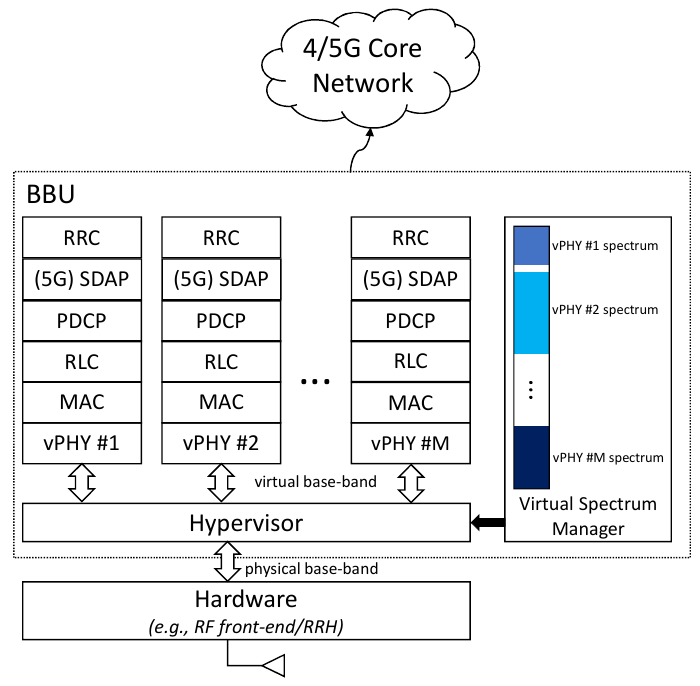
Figure 2. High-level view of a hardware hypervisor in 4G or 5G-like